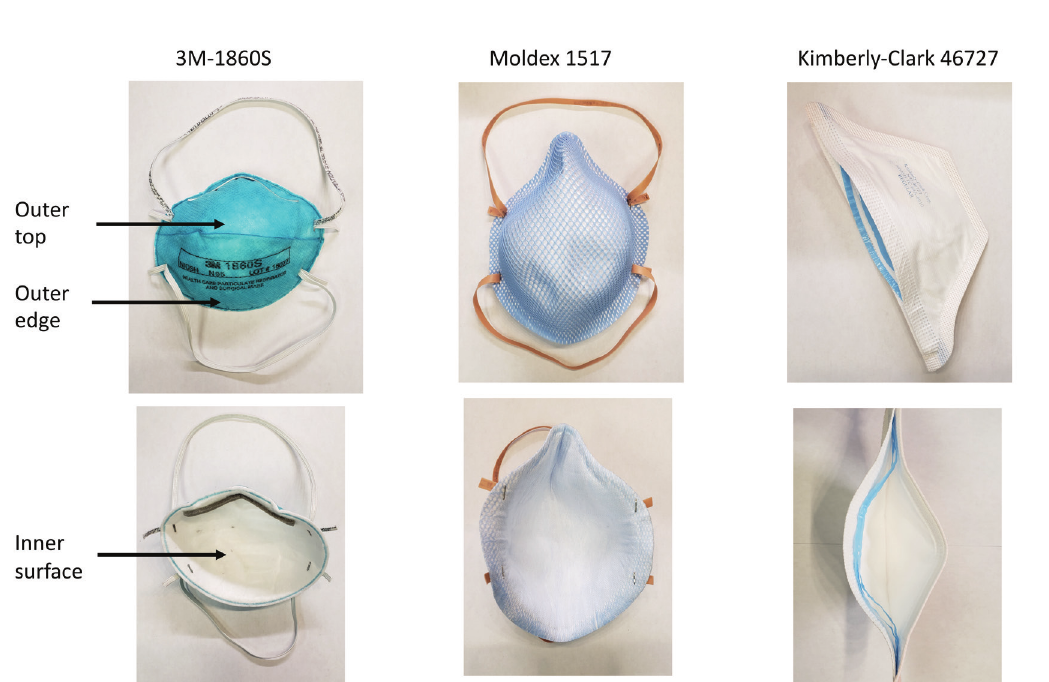
Figure 1 . Pictures of the 3 N95 respirators evaluated in the study and areas where the test organisms were